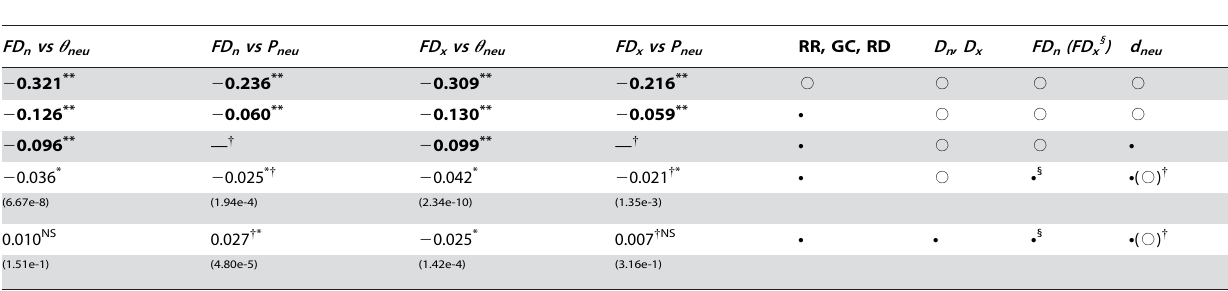
1 Correlation coefficients for FD n versus h neu or P neu was calculated here controlling for FD x and the correlation coefficients for FD x versus h neu or P neu was calculated here controlling for FD n. { Correlation coefficients for FD n or FD x versus P neu were not calculated or were calculated without controlling for d neu , as P neu (= h neu / d neu ) is not independent from d neu . ** P , 1e-10. * 1e-10 # P , 1e-3. NS P . =1e-3. Closed circles ( N ) indicate the controlled variables. Highly significant values (P , 1e-10) are in bold. P -values are given in parentheses for marginally significant (1e- 10 # P , 1e-3) and nonsignificant (NS, P . =1e-3) values.